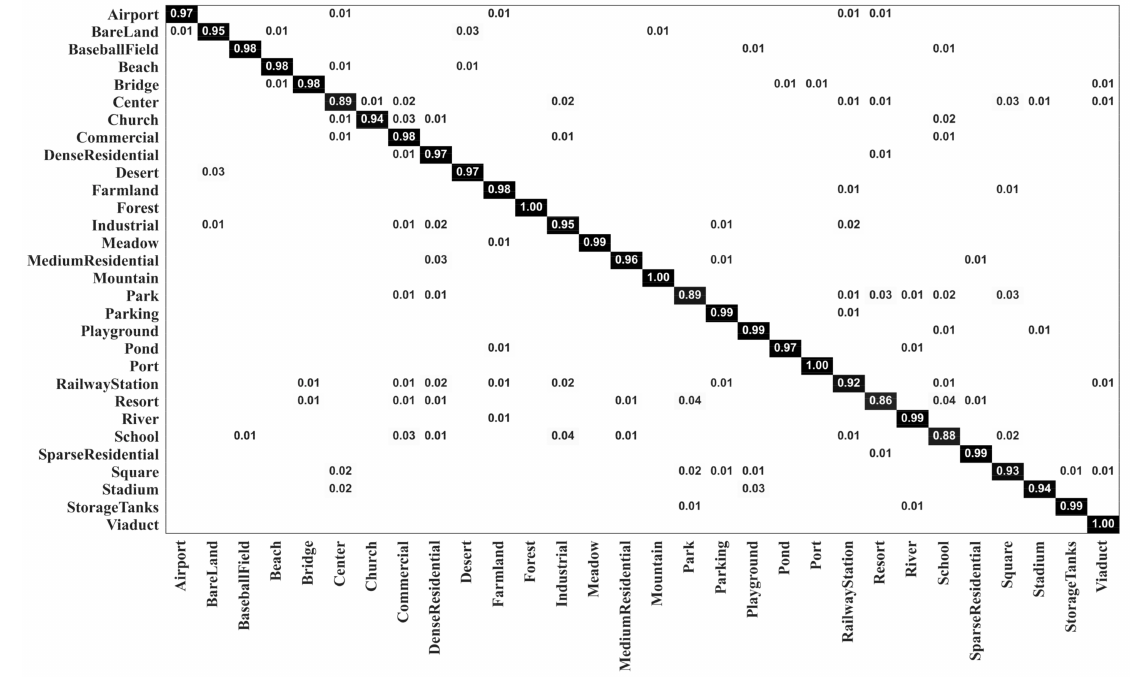
Figure 7. Confusion matrix of MopNet-GCN-ResNet50 on the AID dataset under a training ratio of 20%.